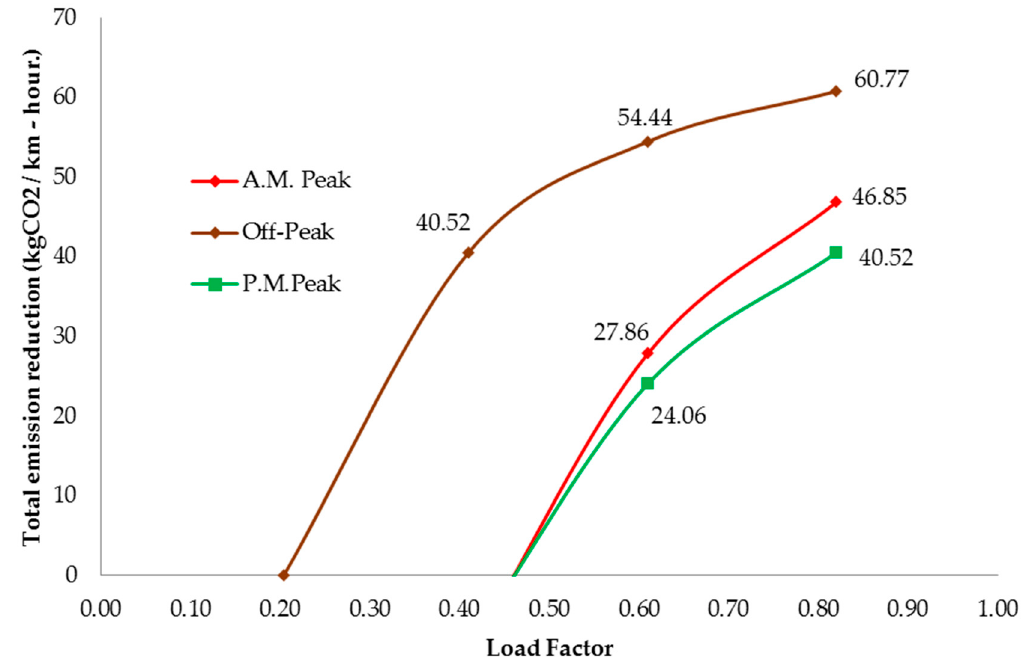
Figure 8. The Relationship between Total Emission Reduction (kg CO 2 / km-hour) and Load Factor (LF) with Different Time Periods.